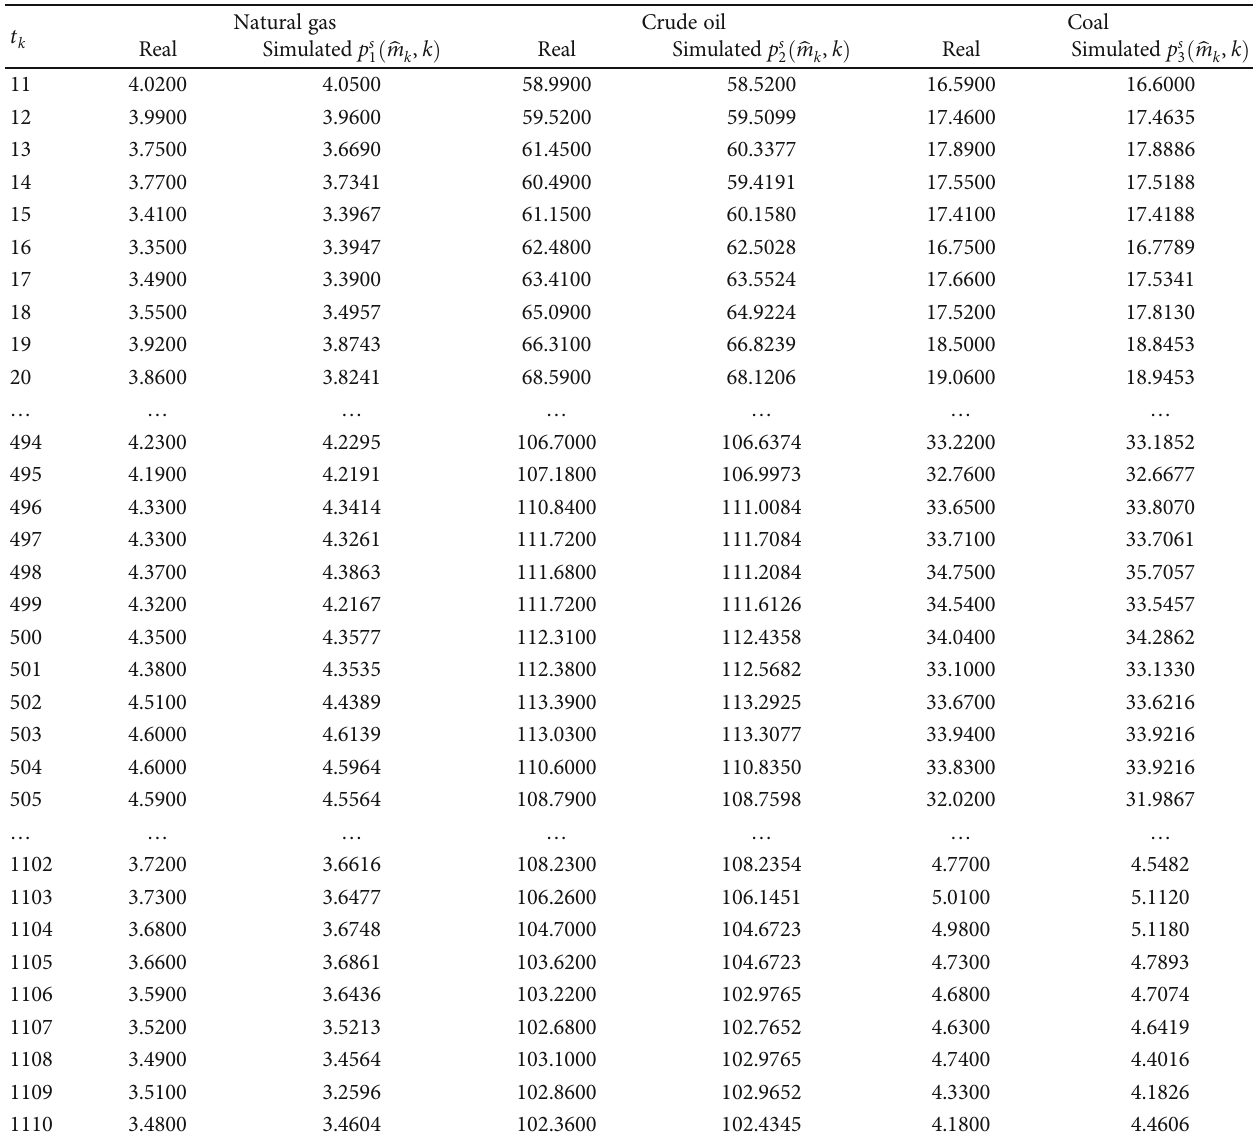
Table 12: Real and simulated estimates (with jump) for natural gas, crude oil, and